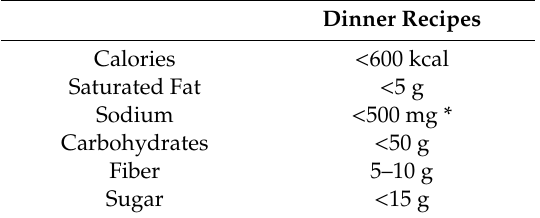
Table 3. Goals for balanced nutrition in Health meets Food